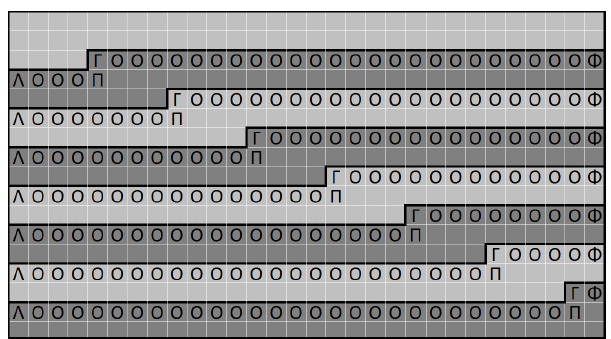
Figure 5. Partitioning of a Full HD frame into 8 slices (marked Coding Tree Units (CTUs) do not have all its neighbors available for